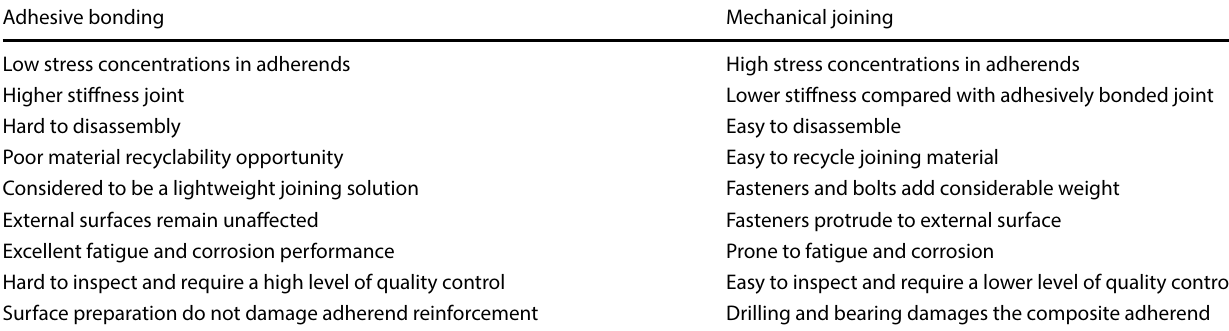
Table 1 Advantages and disadvantages of typical composites’ mechanical and adhesive bonding solutions Adhesive